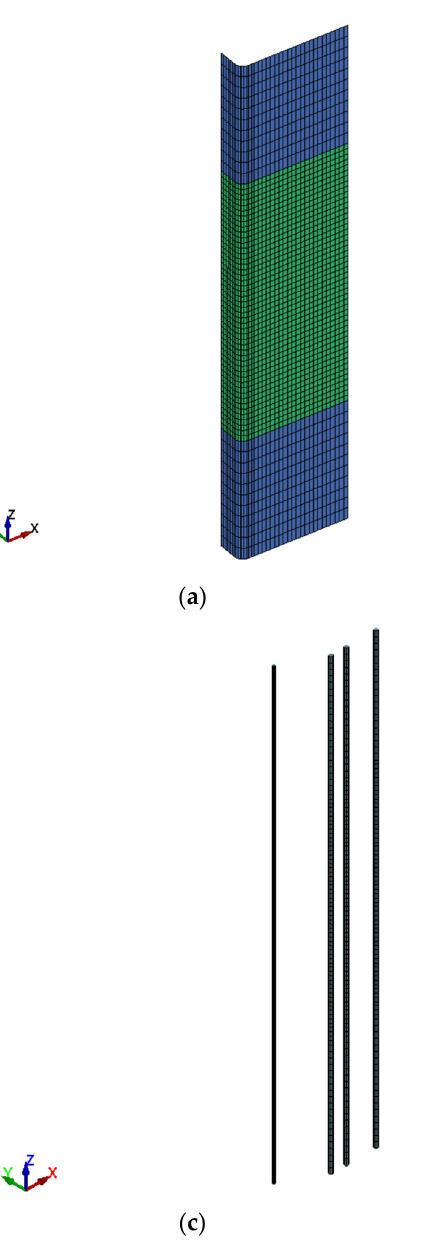
Figure 12. FE geometry for strengthening schemes: ( a ) GFRP sheets for upgraded columns; ( b ) steel plates with rods for specimens S2, S3, and S4; ( c ) NSM bars for specimens S3 and S4; ( d ) epoxy-based mortar for specimens S3 and S4.